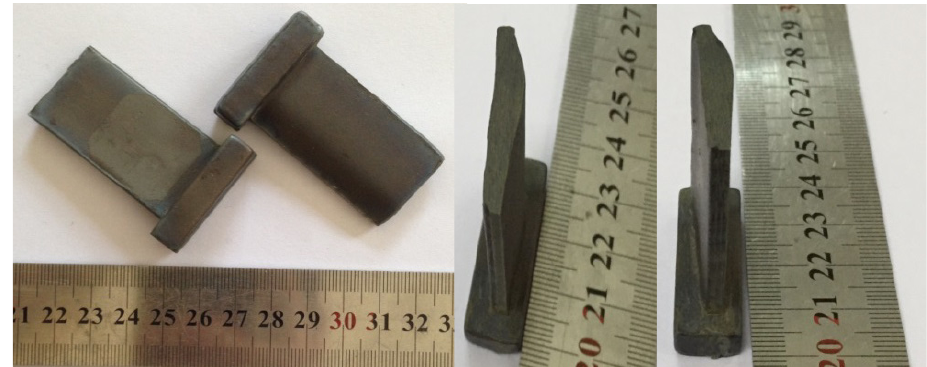
Figure 8. Images of the sandblasted high Nb–TiAl alloy blades.